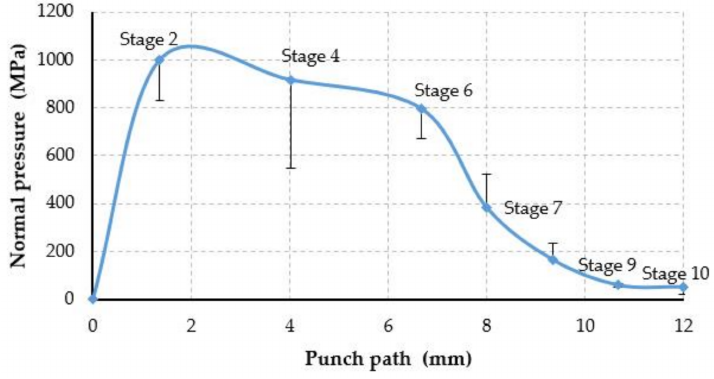
Figure 14. The dependence normal pressure based on the punch path during the hole-flanging